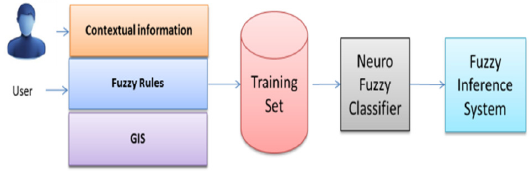
Figure 2. An overview of the proposed